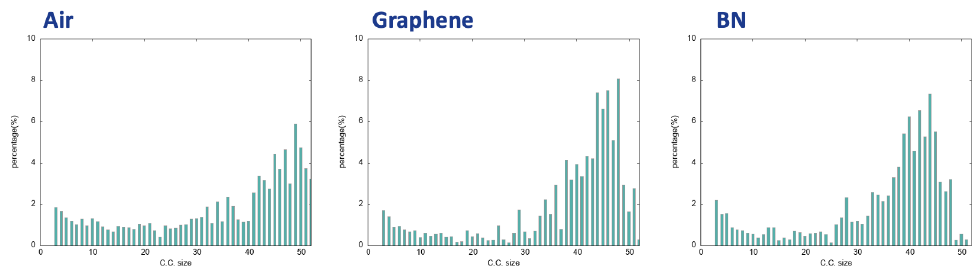
Figure 8. Distribution of the connected components of the 2D-MolGraphs (condensed phase, see text for details) for the air/liquid water interface ( left ), the Graphene/liquid water ( middle ), and the BN/liquid water ( right